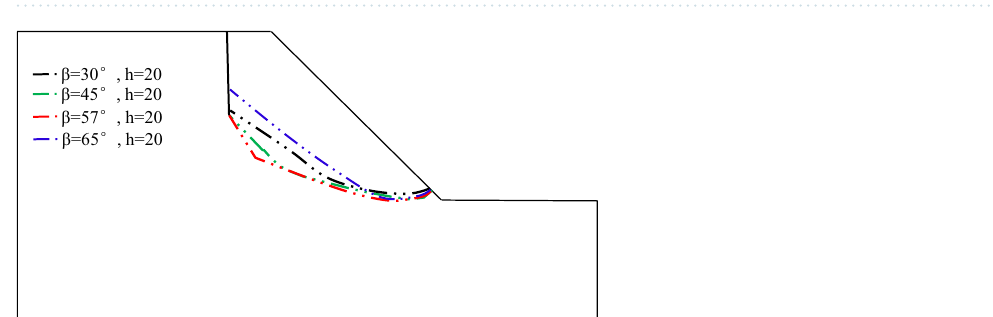
β=30 (cid:101) , h=20 β=45 (cid:101) , h=20